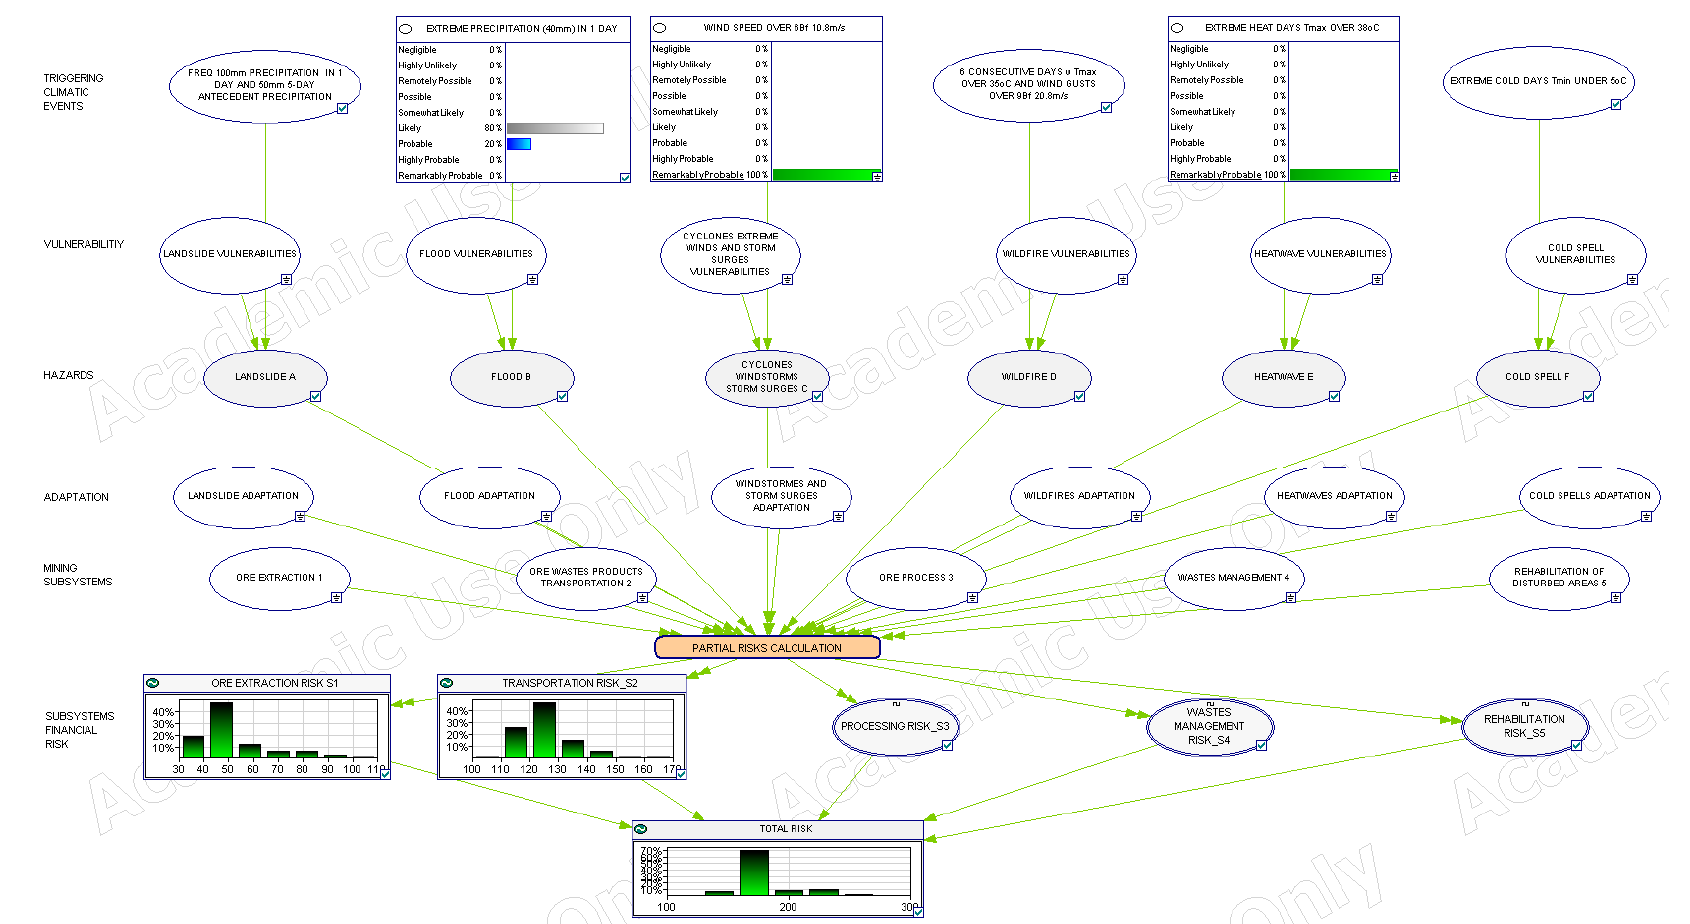
Figure 4. Conditional Linear Gaussian Model for CLIRMI mine main part.